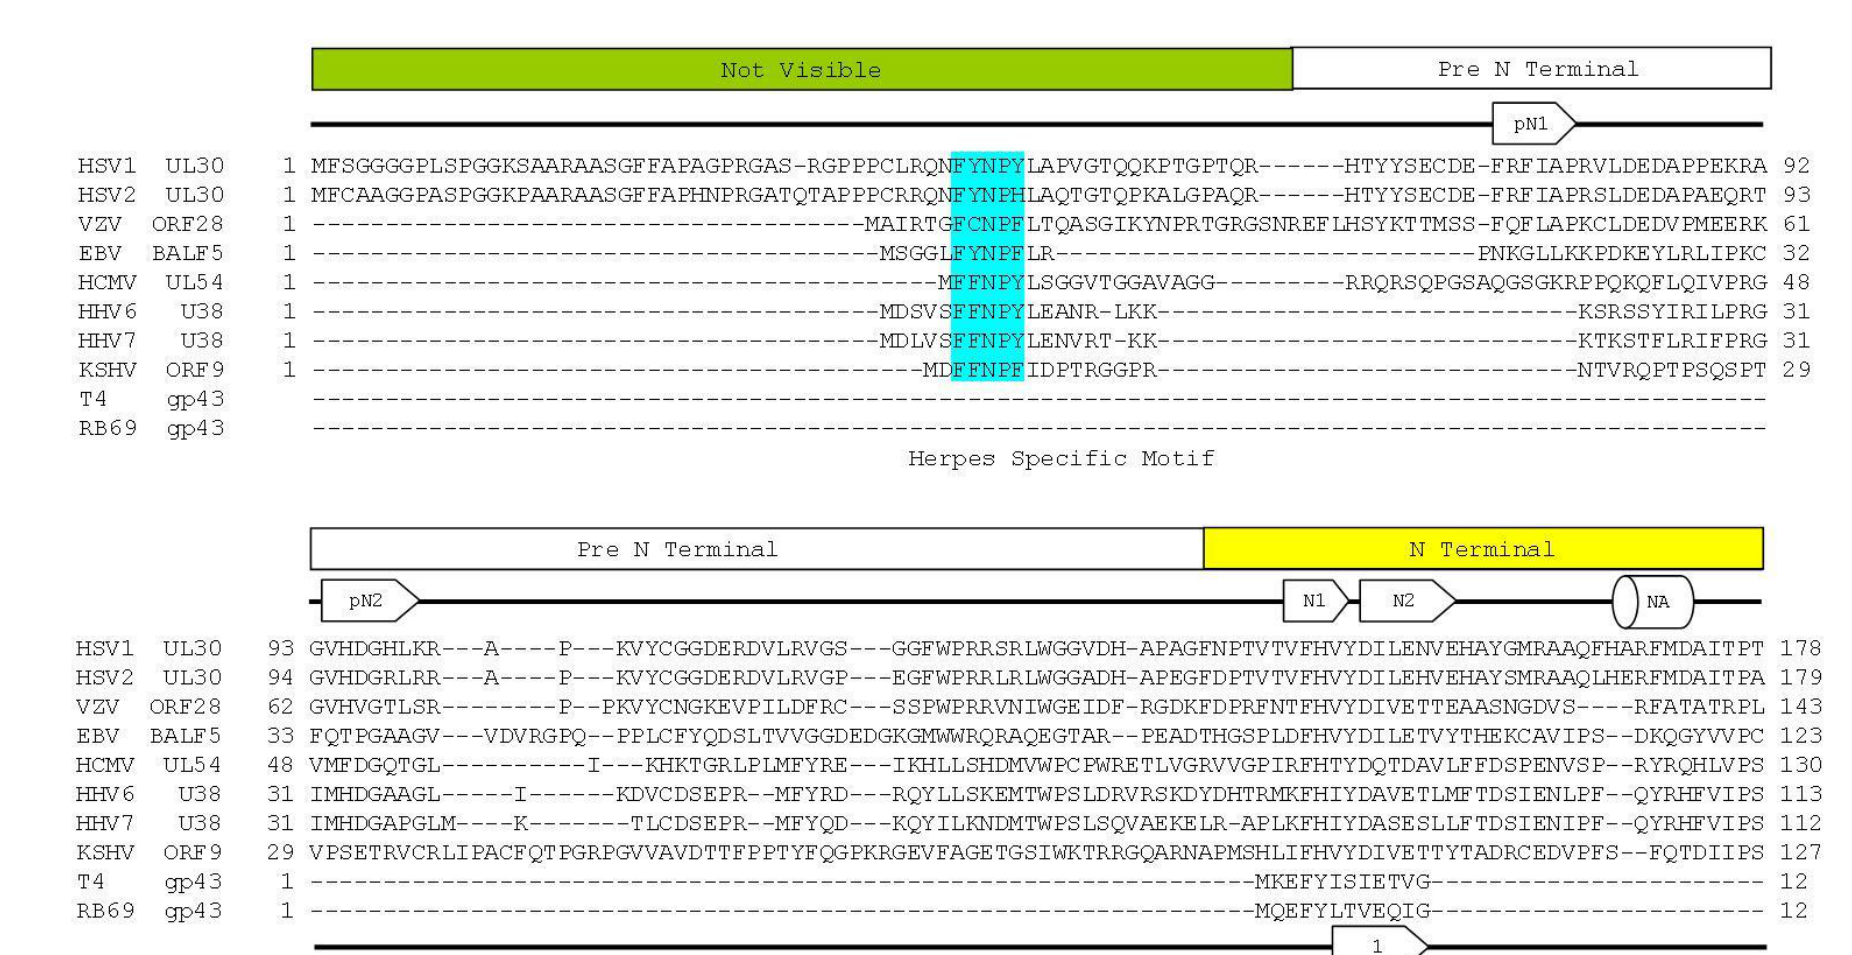
Appendix Figure A1.